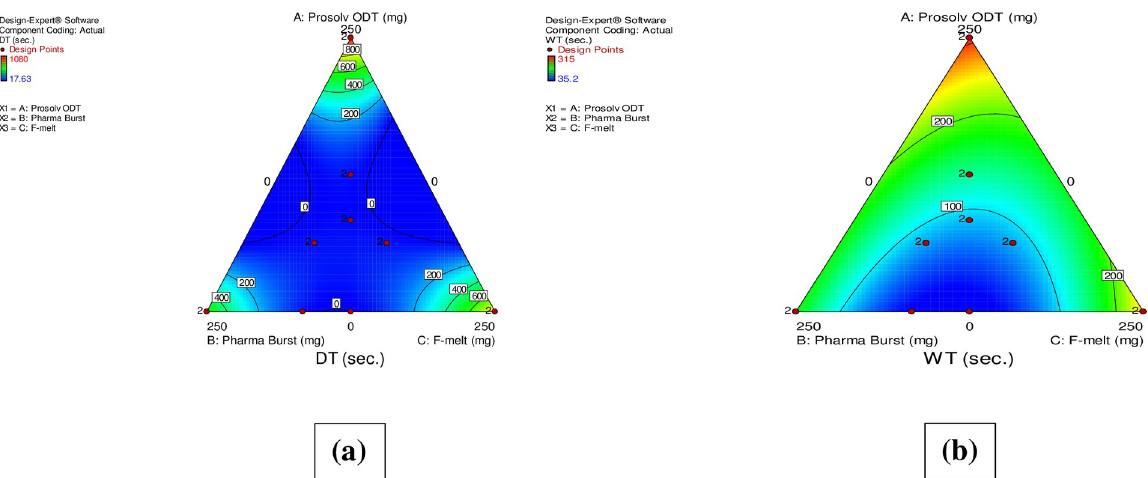
Fig 3. Contour plots of the effect of formulation variables on DT (Y 4 ) (a) and WT (Y 5 ) (b) on